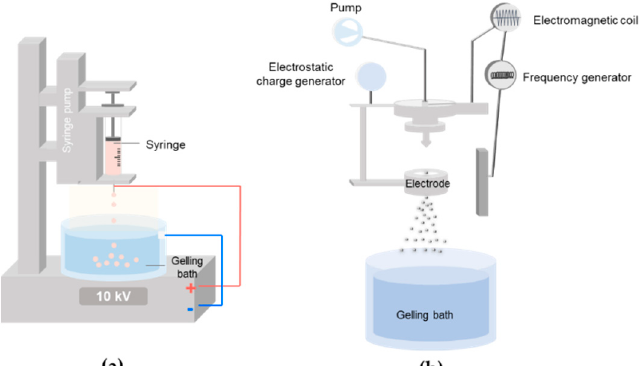
Figure 3. Electrospraying for microbeads production and stem cell encapsulation. Illustration of a typical electrospraying process ( a ) and a vibration nozzle-equipped system ( b ).